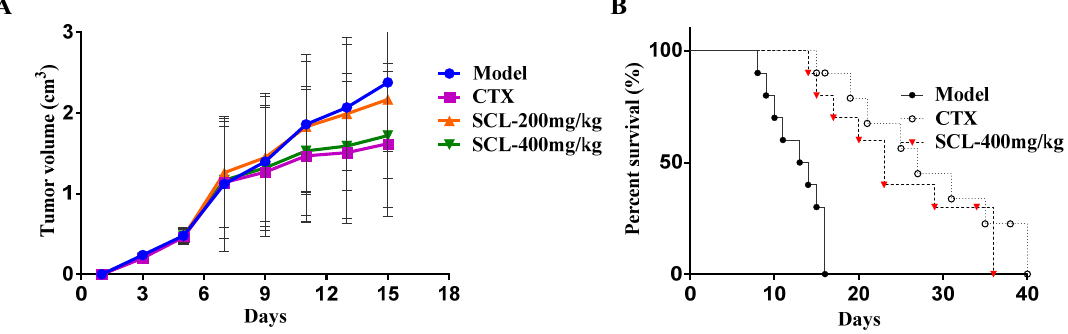
Figure 2. The effects of steamed C . lanceolata (SCL) on tumor growth ( A ) and life extension in H22 tumor-bearing mice ( B ). n = 10.